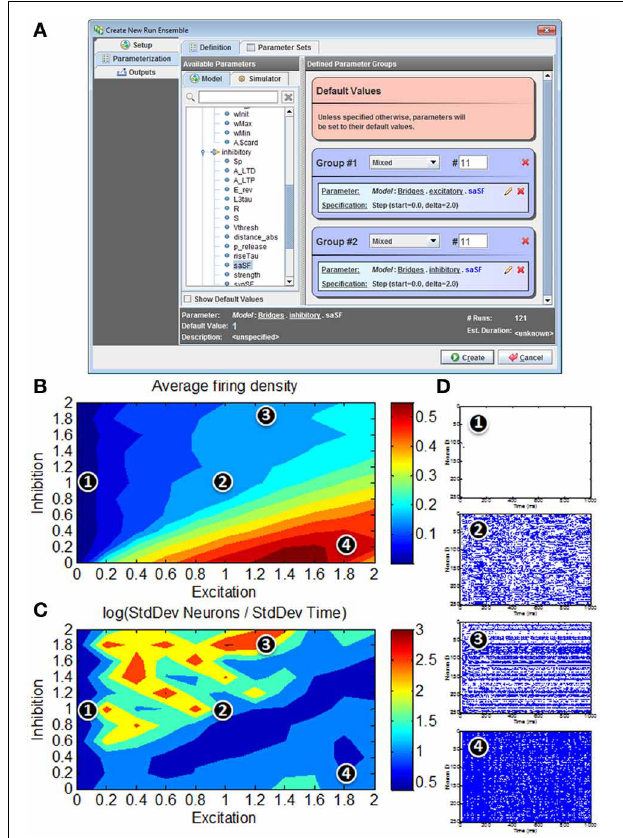
FIGURE 9 | Model simulations of 80/20 E-I network in N2A. (A) Screenshot of parameter search window within N2A; any model parameter can be varied either randomly or systematically and in isolation or in conjunction with other parameters. (B) Firing rates in response to parameter sweep of differing E and I synaptic conductance levels. (C) Distribution of activity in response to parameter sweep. (D) Representative raster plots of spiking from E-I network at different positions in parameter state space; 1—all neurons effectively silent; 2—asynchronous firing dynamics; 3—skewed firing dynamics, with subset of neurons exhibiting persistent activity; 4—hyperactive network with most neurons persistently active.